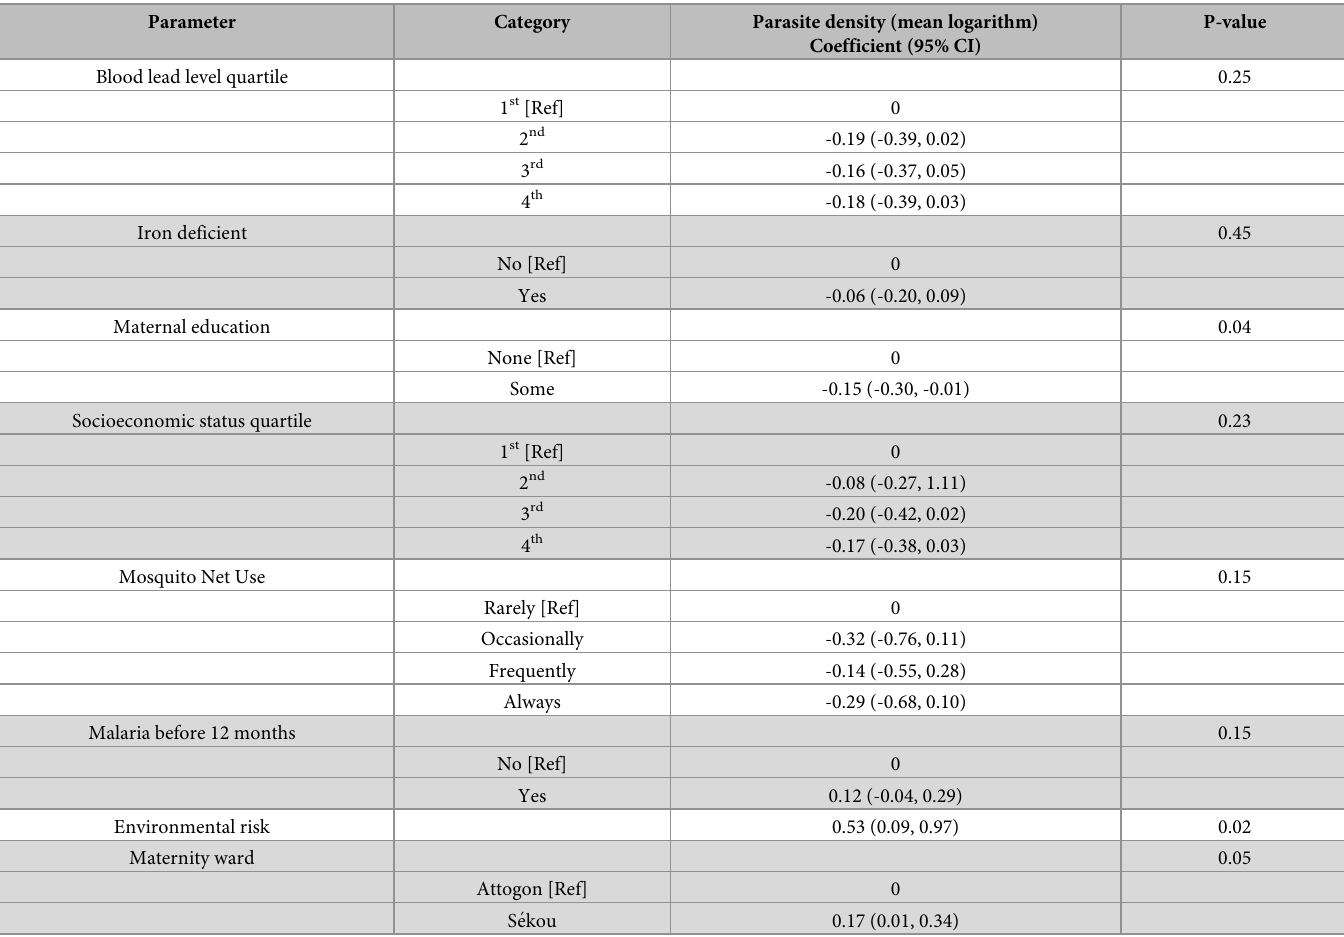
Table 3. Univariate linear regression between potential confounders and mean logarithm parasite density † .